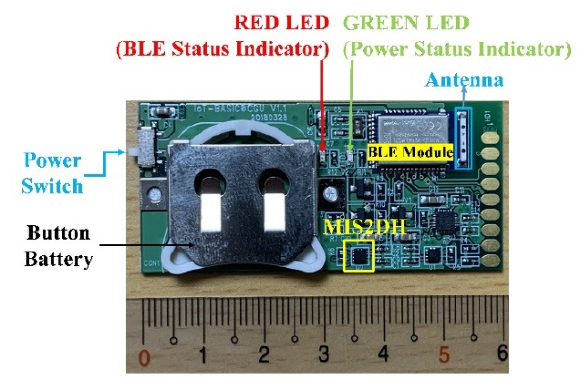
Figure 3. Prototype of the BASIC module.